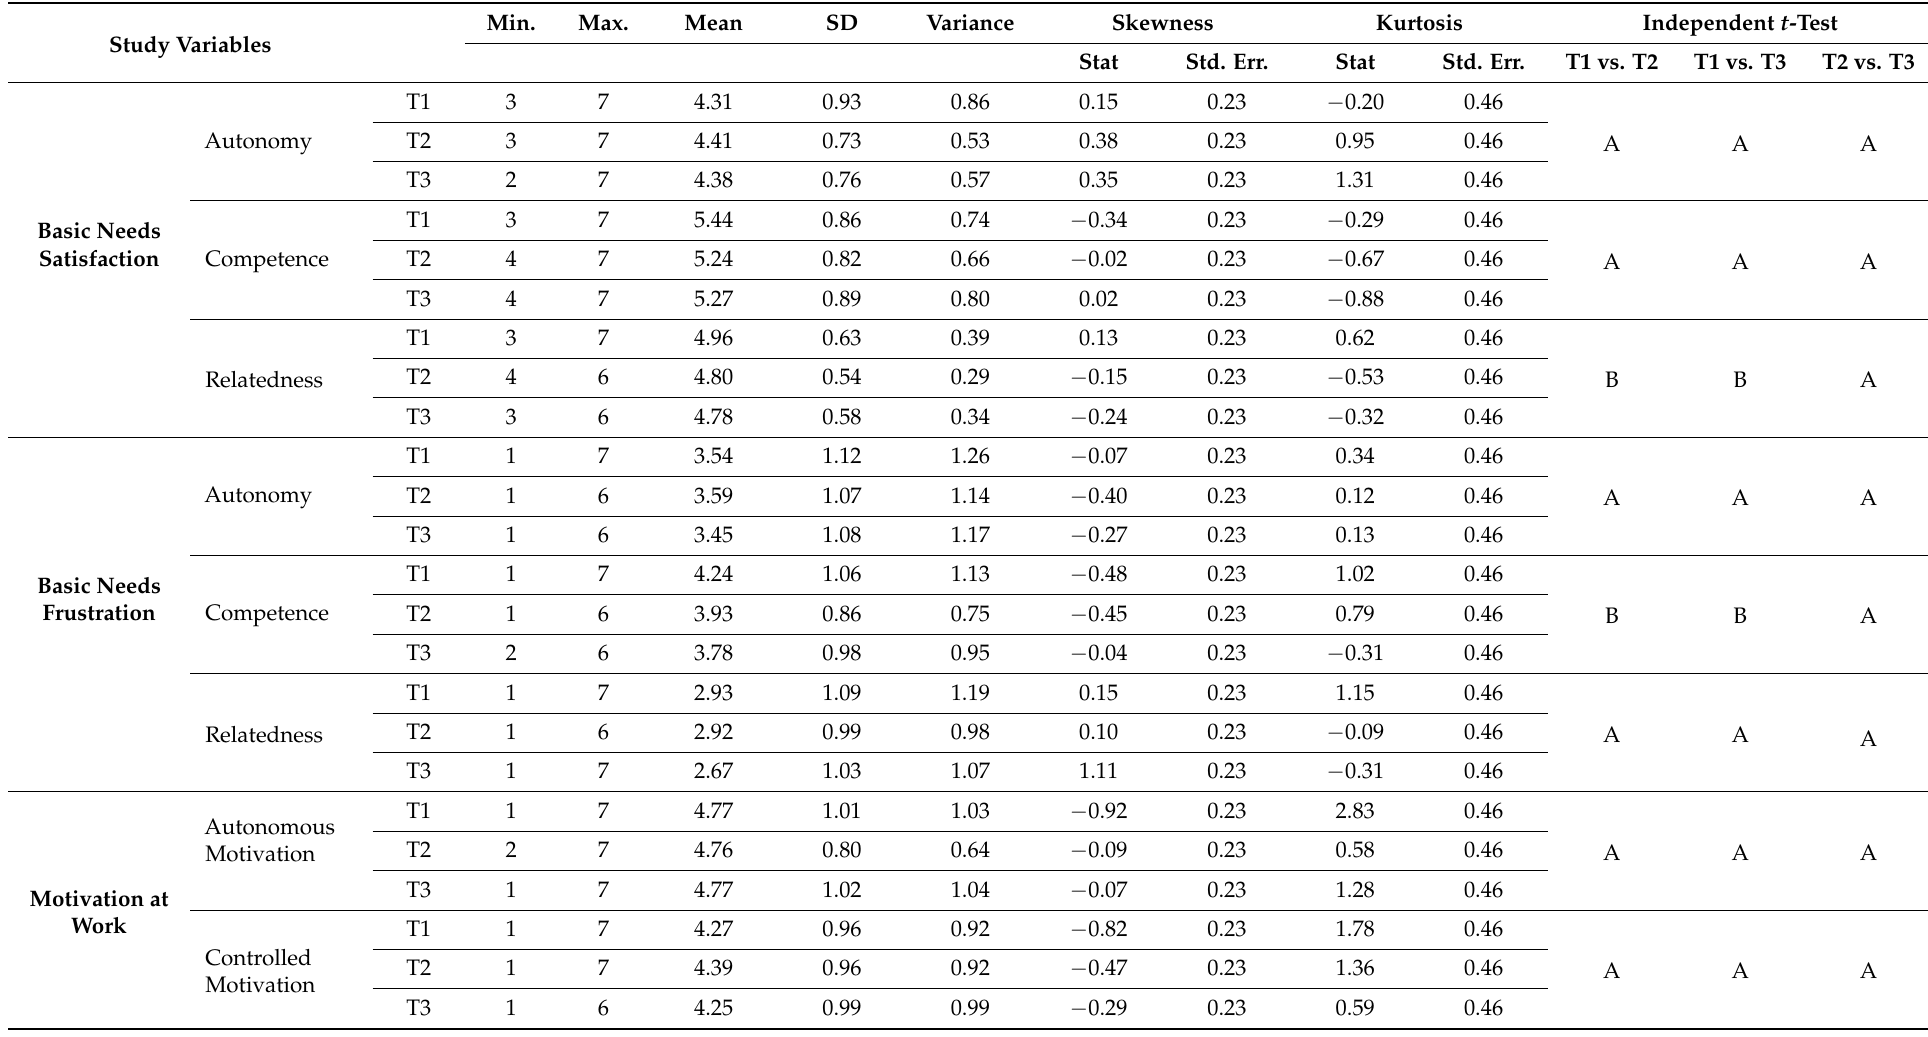
Table 1. Descriptive Statistics for Study